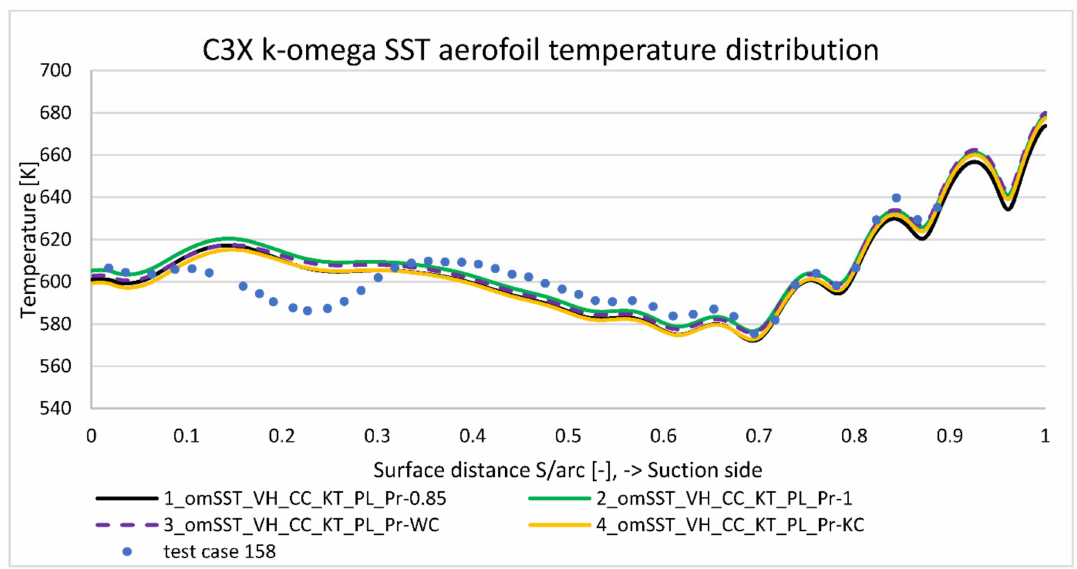
Figure 16. Suction side temperature distribution comparison according to Prandtl number